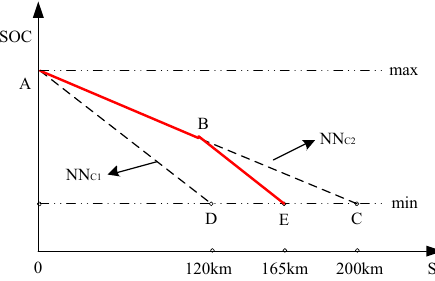
Figure 12. Battery SOC variation for an atypical driving distance to illustrate the selection methods in